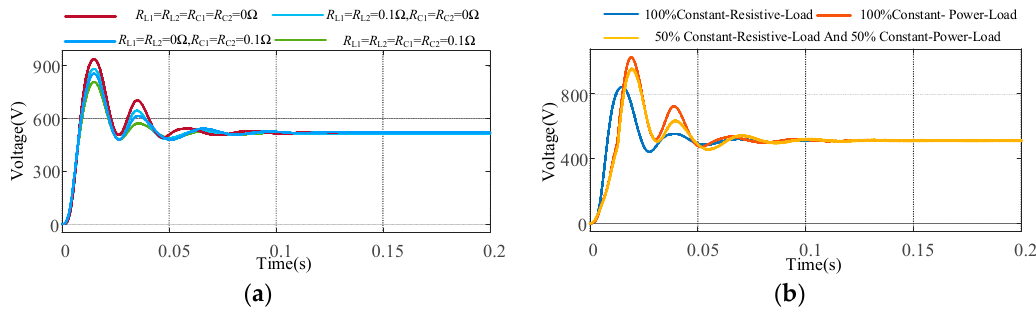
Figure 20. Comparison of the filtering performance for different cases. ( a ) Damping resistance is located in different branches of the filter and ( b ) Various types of DC loads.